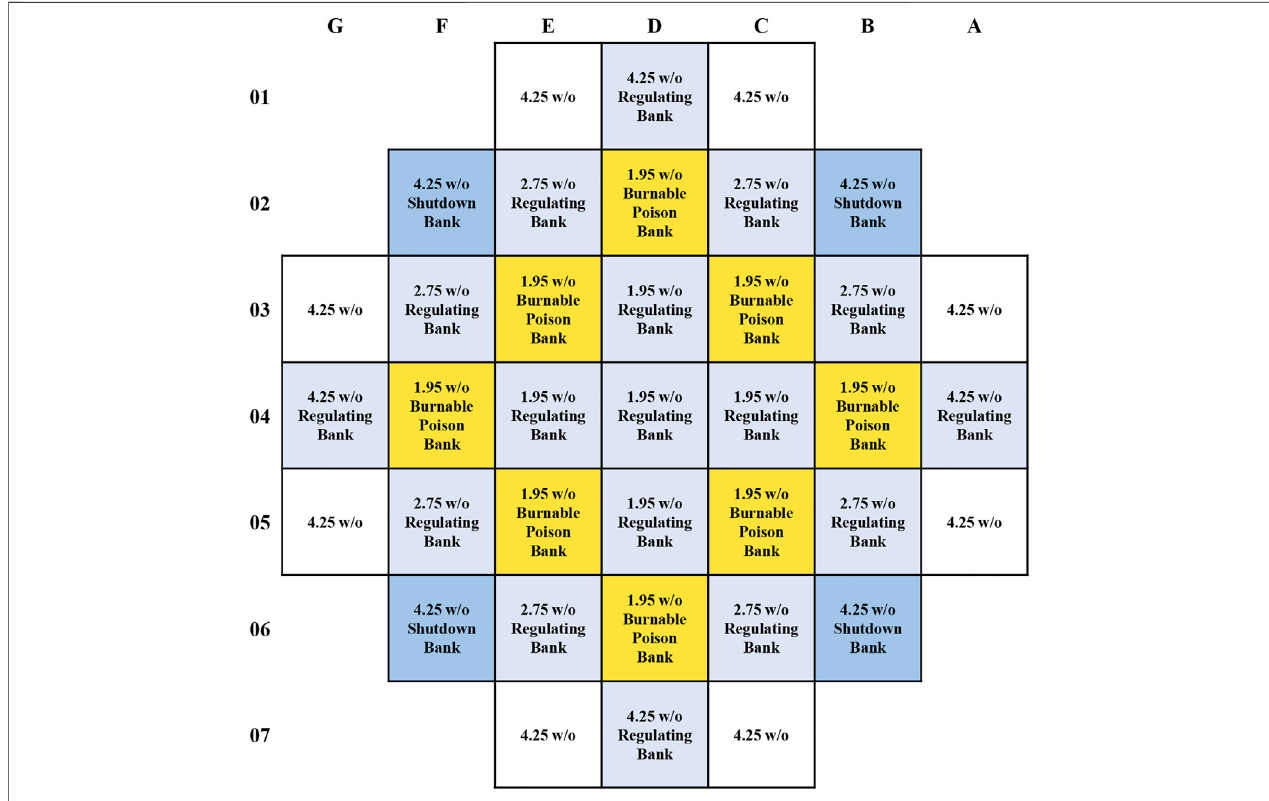
FIGURE2| Schematicdiagramofthearrangementof37FAs.Differenttypesareshownwithdifferentcolors(darkblue,shutdowncontrolrodassemblybank;blue, regulating control rod assembly bank; yellow, burnable toxic rod assembly bank; white, assemblies that contain neither control rods nor burnable toxic rods).